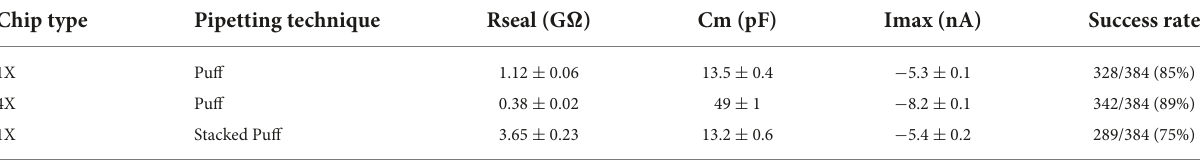
Shown are parameters for Rseal (for last sweep of the experiment), cell capacitance (Cm) and current amplitude (Imax) of the 1st sweep to pH 6.5. Success rate is calculated for fraction of cells across each 384 well plate meeting or exceeding minimum quality criteria. Using single “puff” applications of pH 6.5 solution in single hole chips, we obtained small molecule reference pharmacology data on the SP384i that were very similar to potencies seen on the other APC platforms in this study and from the literature. Amiloride inhibited peak current with an IC 50 of 5.90 ± 0.31 µ M (Mean ± S.E.M, n = 193) and a Hill slope of 1.20 ± 0.05, while Benzamil exhibited a slightly higher potency of 1.37 ± 0.07 µ M (Mean ± S.E.M, n = 224) andaHillslopeof1.07 ± 0.02( Table4 ).